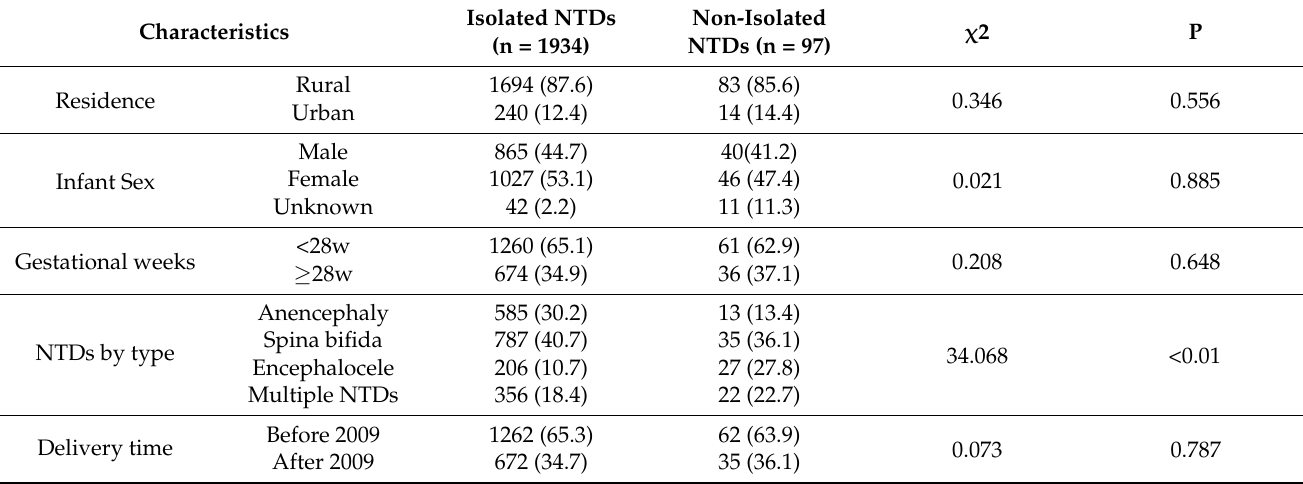
Table 2. Characteristics of isolated and non-isolated NTD cases in five counties in Shanxi province of Northern China, 2002–2021, N